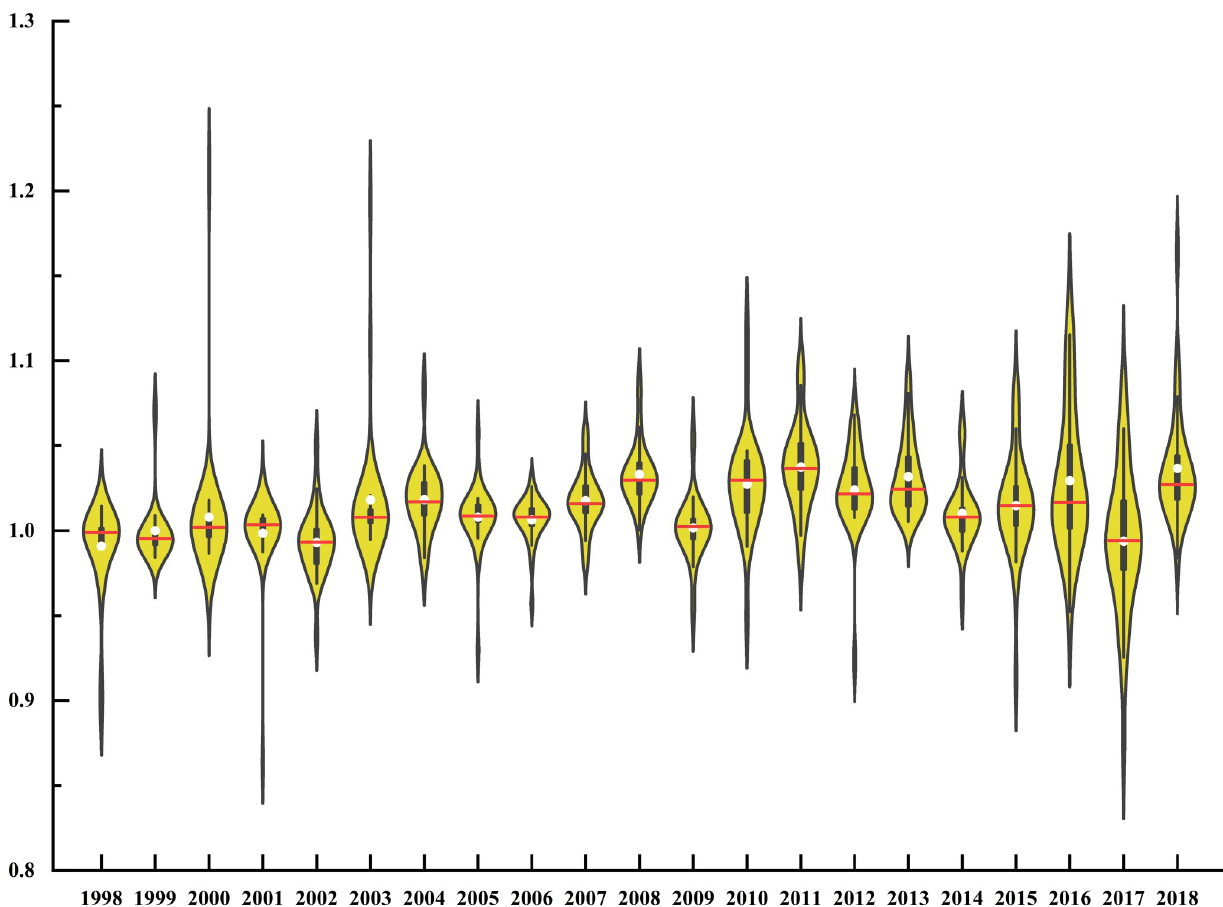
Fig 2. Variation of GATFP in China from 1998 to